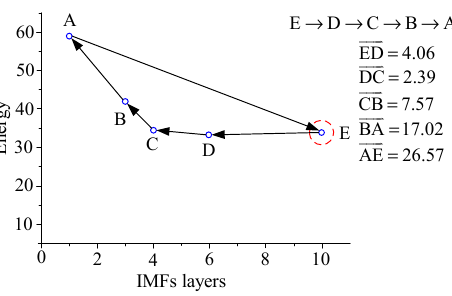
Figure 14. Shortest path of start node E.